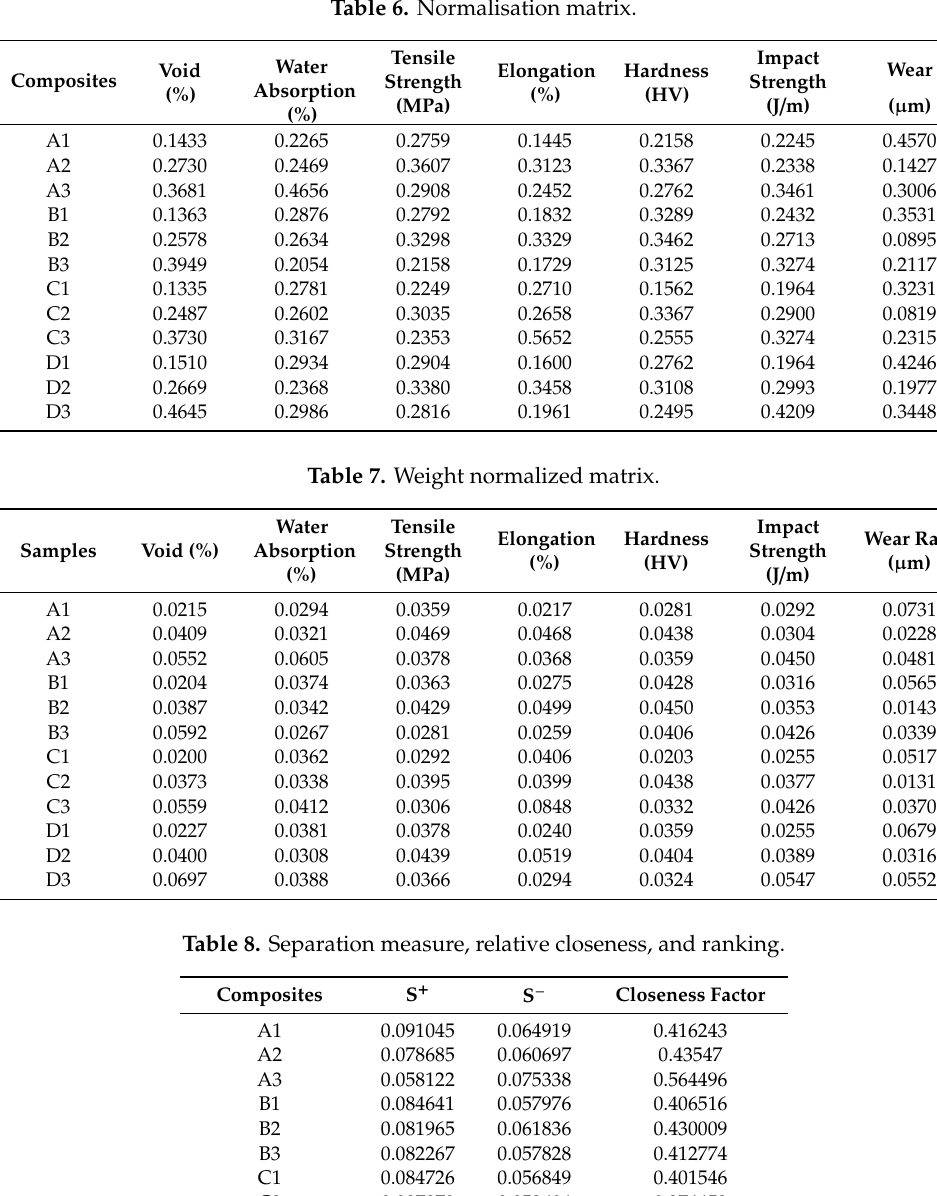
Table 6. Normalisation matrix.